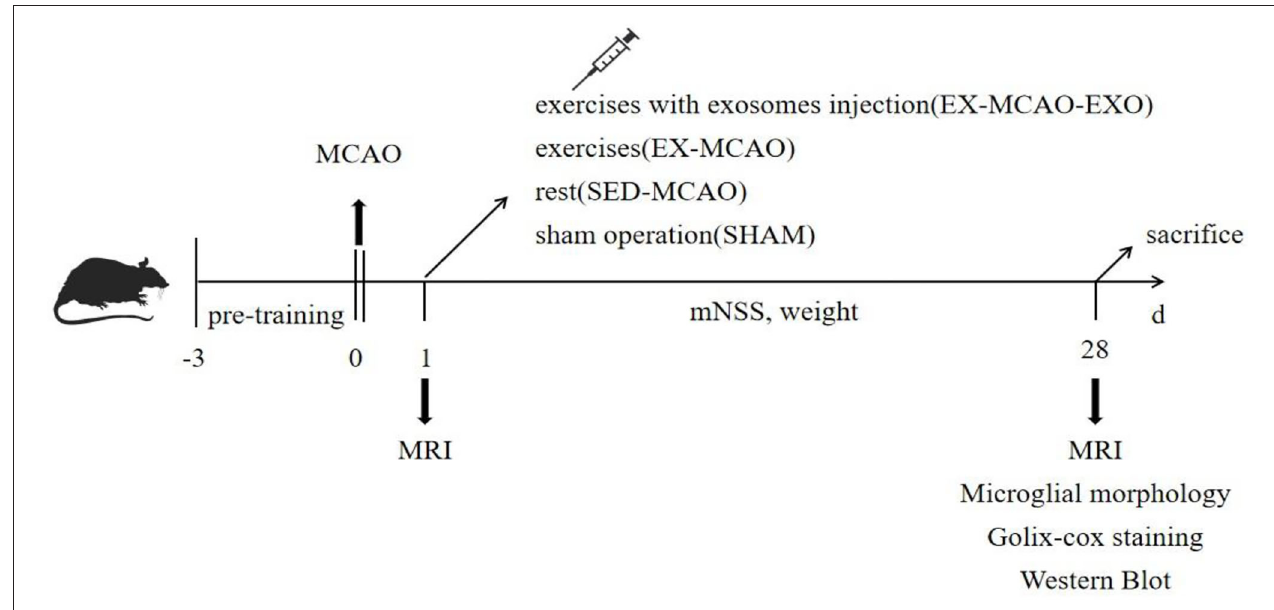
FIGURE 1 | Schematic of the experimental protocol.